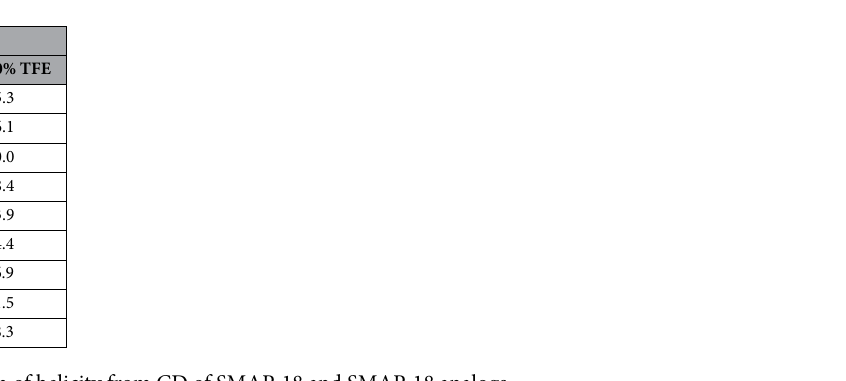
Table 2. Estimation of helicity from CD of SMAP-18 and SMAP-18